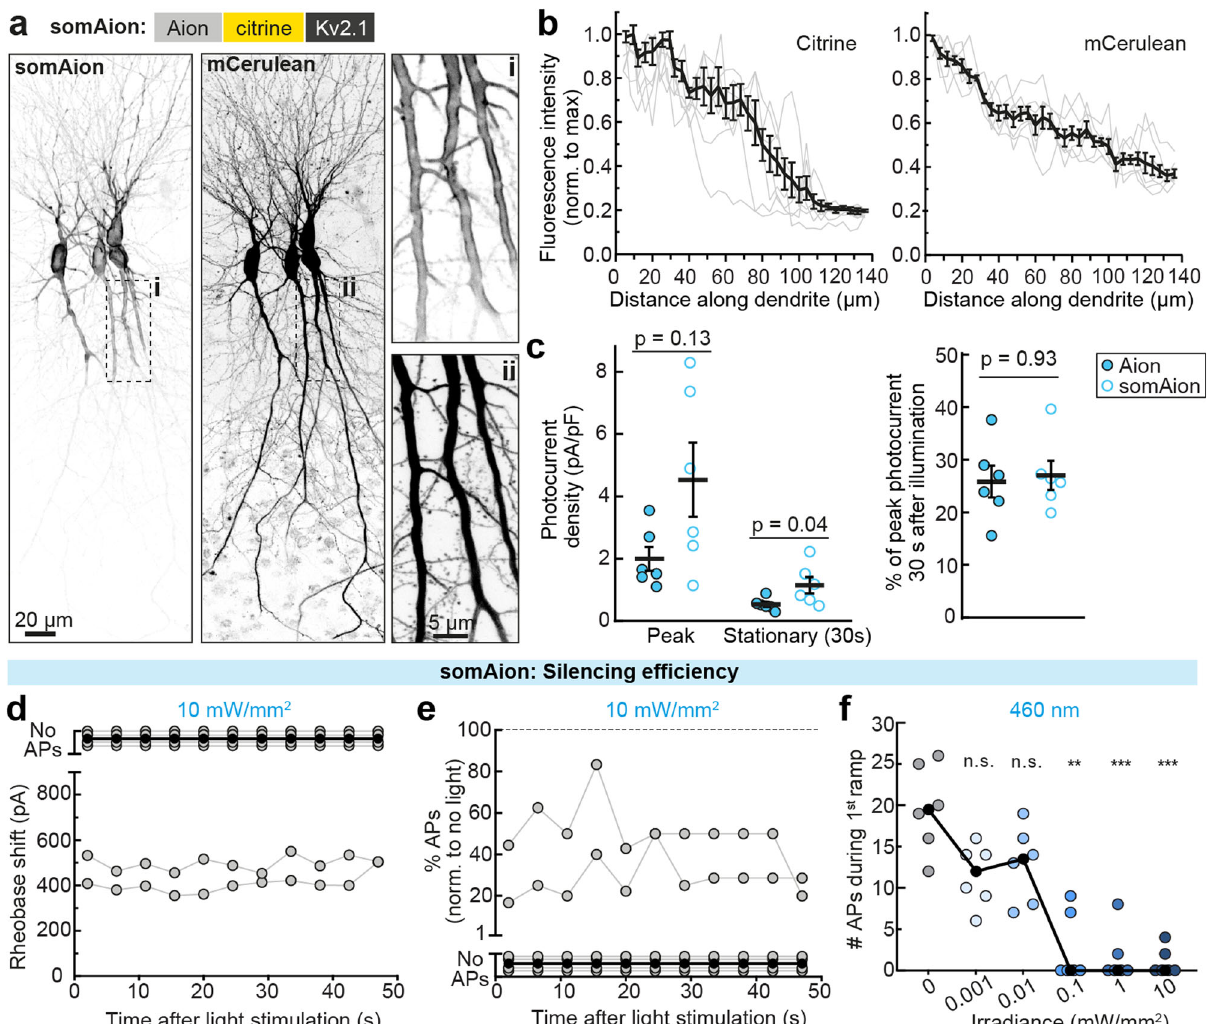
Fig. 5 somAion is a soma-targeted variant of Aion with enhanced silencing capacity. a Maximum-intensity projections of two-photon image stacks showing expression of somAion in CA1 pyramidal neurons after single-cell electroporation in organotypic hippocampal slice cultures. Fluorescence intensity is shown as inverted gray values. Opsin-citrine fl uorescence was localized at the plasma membrane and restricted to the somatodendritic compartment (left image, inset i). mCerulean serves as a morphology marker (right image, inset ii). b Quanti fi cation of citrine and mCerulean fl uorescence along the main apical dendrite of somAion-expressing neurons ( n = 7 cells). Gray lines correspond to measurements in individual cells. Black lines indicate mean ± SEM. c Comparison of Aion and somAion peak and stationary (30 s post light) photocurrent densities evoked by a short 460-nm light pulse (1 s, 10 mW/mm 2 ). Right: quanti fi cation of stationary, peak-normalized photocurrent amplitude at 30 s after channel opening. Black lines indicate mean ± SEM and circles represent measurement from single cells ( n Aion = 6 cells, n somAion = 6 cells). Mann – Whitney test, exact p -values are shown. d – f Rheobase measurements as described previously. d Quanti fi cation of the rheobase shift and ( e ) the relative change in the number of current ramp-evoked APs during 47 s after light stimulation (460 nm, 1 s, 10 mW/mm 2 , n = 6 cells). In most cells, activation of somAion led to complete AP block. f Number of APs evoked during the fi rst current ramp after opening of somAion with 1 s blue light at indicated irradiances. Signi fi cant AP block was achieved at 0.1 mW/mm 2 ( n = 6 cells). For d – f gray or blue circles represent single measurement data points and black fi lled circles correspond to medians, Friedman test, * p < 0.05, ** p < 0.01, *** p < 0.001, n.s. not signi fi